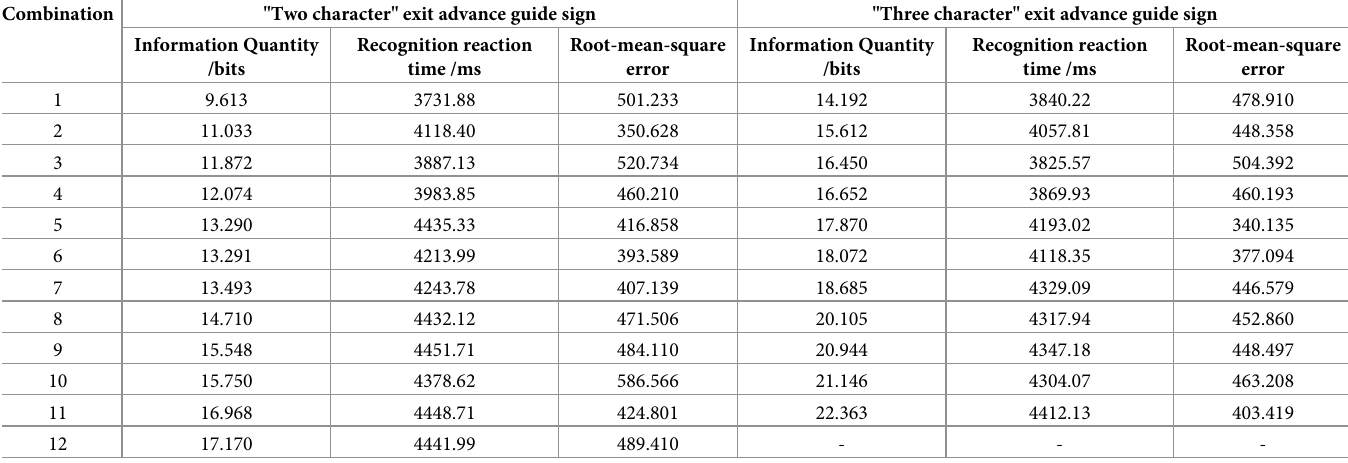
Table 10. Average recognition reaction time of drivers under different information combinations.